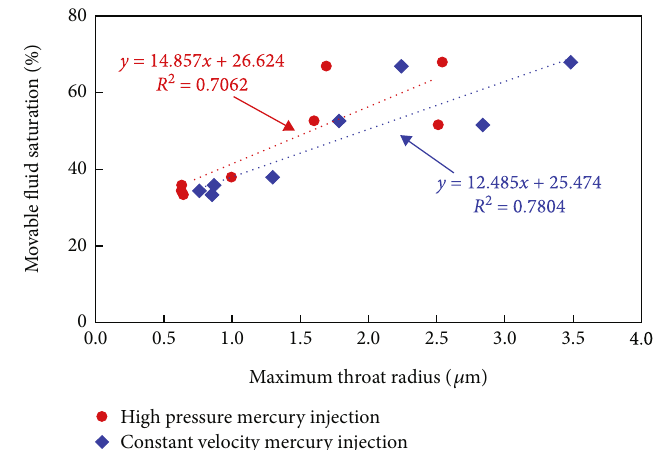
Figure 17: Relationship between maximum throat radius and movable fl uid